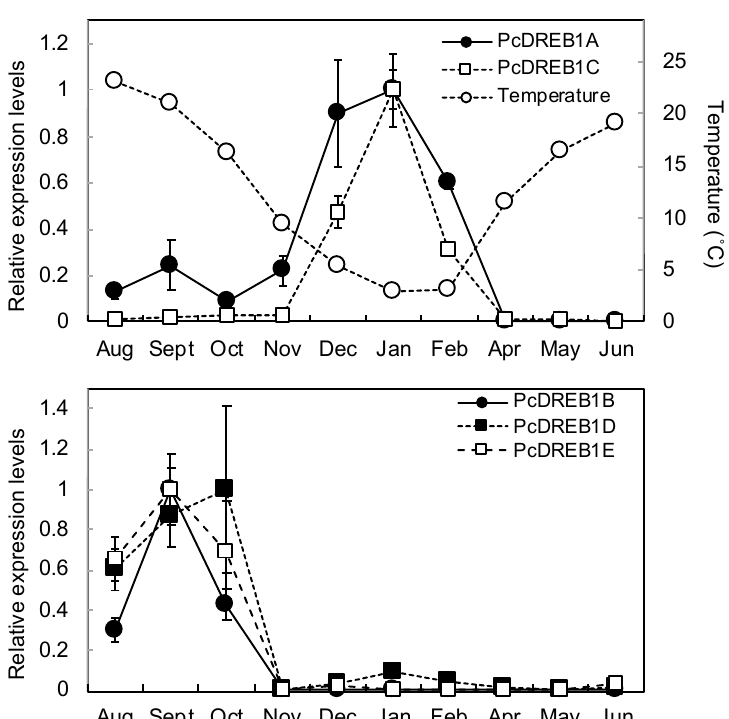
Figure 5. Seasonal changes in the mRNA levels of PcDREBs in wildtype pear vegetative buds at air temperature: each value was determined from three independent biological replicates. Data show the relative expression levels normalized against PcGAPDH . Values indicate the means ± standard error ( n = 3).